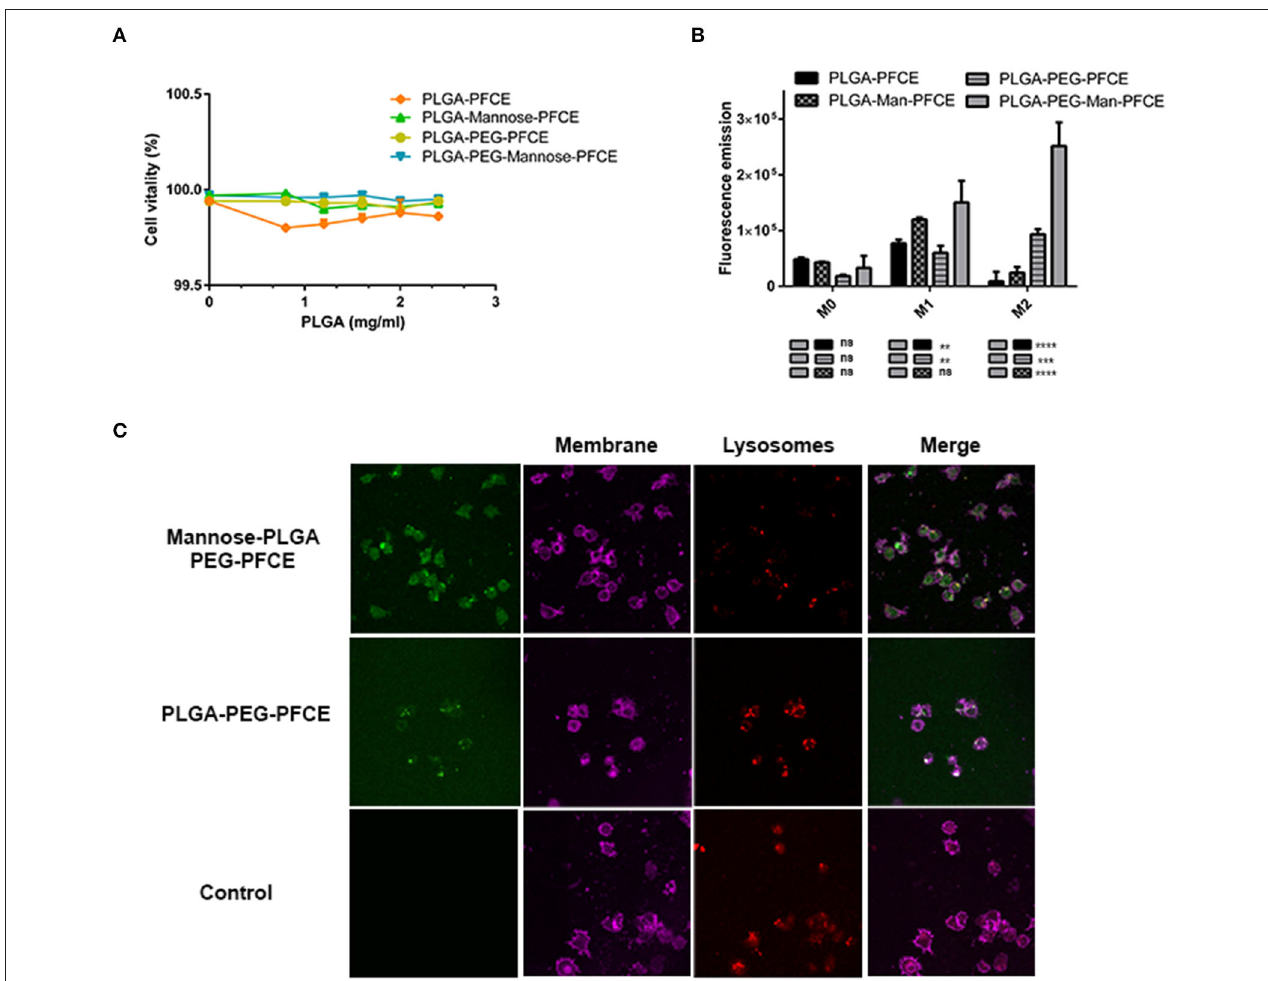
FIGURE 2 | Characterization of nanoparticles in vitro . (A) Cytotoxicity tests for Raw264.7 macrophage cells treated for 24h with PLGA-PFCE, PLGA-PFCE-Mannose, PLGA-PEG-PFCE, and PLGA-PEG-mannose-PFCE nanoparticles (final concentration 1 mg/ml). (B) Uptake efficiency of Raw264.7 macrophage cells polarized in M0 (negative control), M1 (pro-inflammatory), M2 (anti-inflammatory) phenotype and treated for 1h with PLGA-PFCE, PLGA-PFCE-mannose, PLGA-PEG-PFCE and PLGA-PEG-mannose-PFCE nanoparticles (final concentration 1 mg/ml). (C) Confocal images of polarized M2-polarized Raw264.7 macrophages treated for 1h with mannose (top) and untargeted (middle) PLGA-PEG NPs. Negative control for PLGA-PEG nanoparticles is shown in the bottom panels. Nanoparticles are shown in green color (FITC labeled); cell membrane is shown in magenta color; lysosomes are shown in deep-red